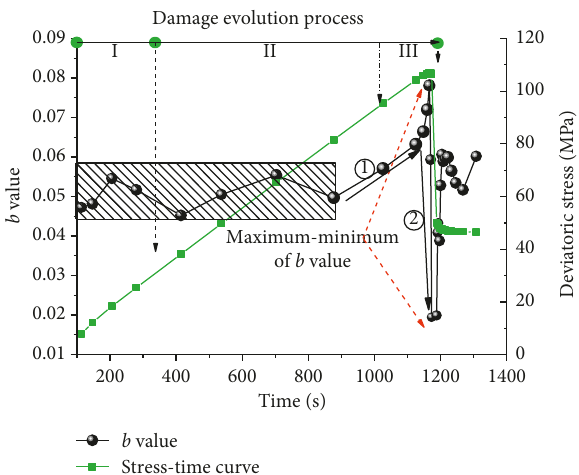
Figure 17: Stress time b value correlation change rule